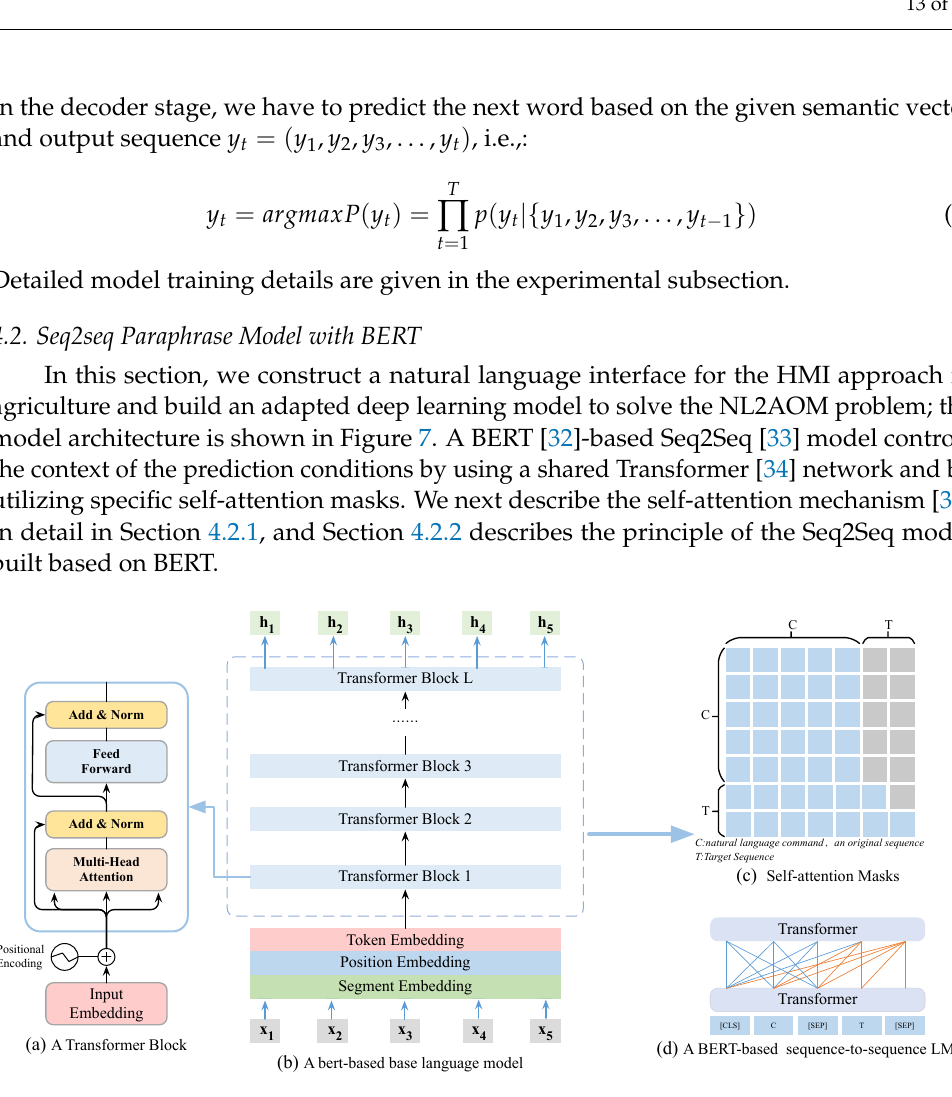
Figure 7. BERT-based Seq2Seq language